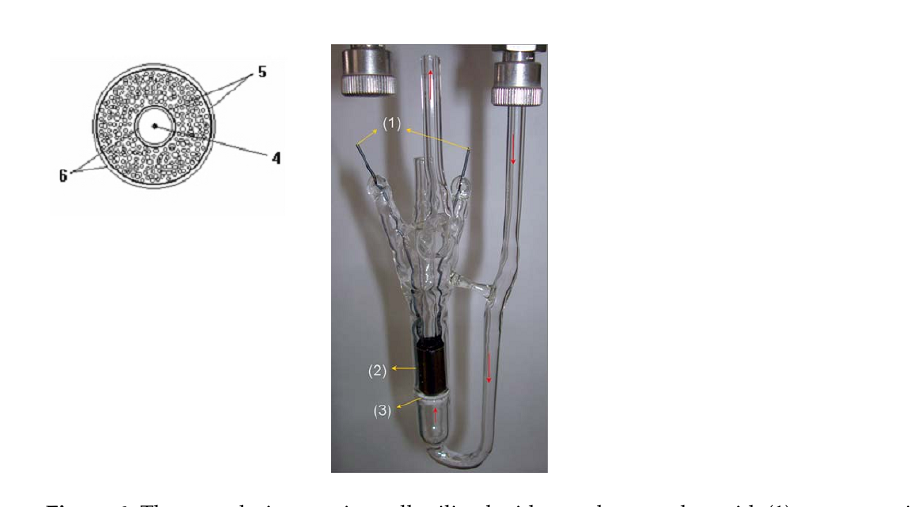
Figure 5. Gas-sensing experimental setup used for powder-type sensitive samples, with (1) carrier and target gas cylinders, (2) MFC system, (3) gas sensing cell, (4) programmable furnace, (5) RLC bridge, (6) data acquisition computer, from ref. [8].